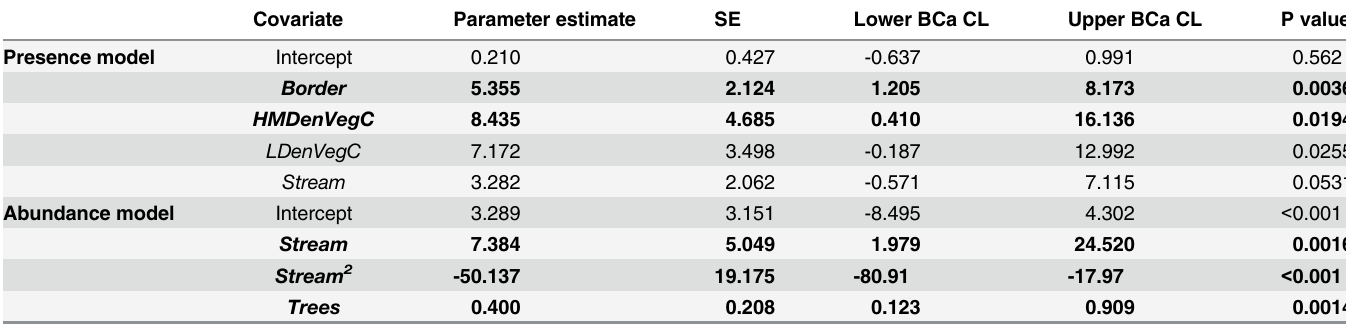
Table 4. Parameters of the final